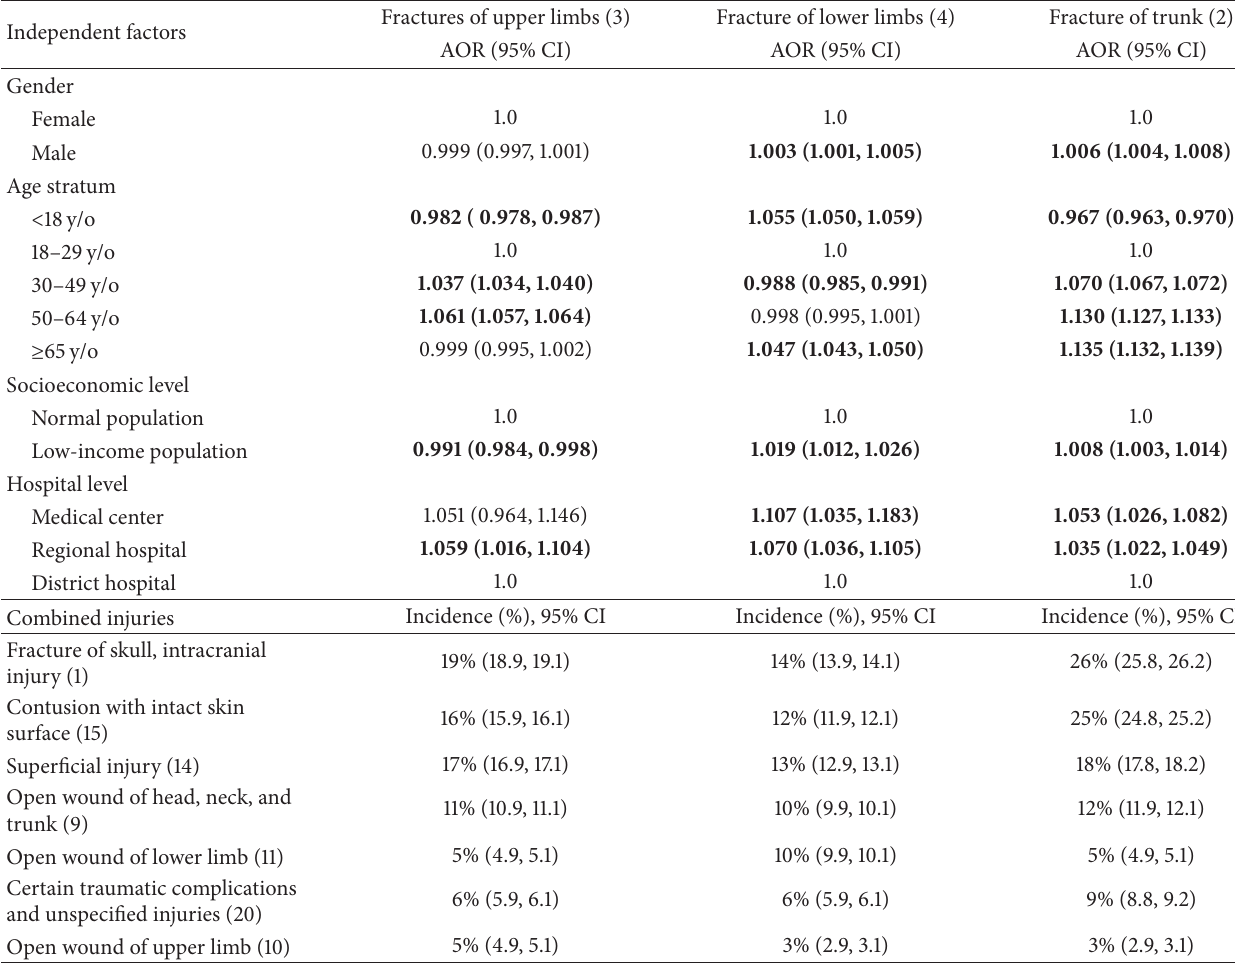
Table 3: Individual and cluster differences of orthopedic fractures analyzed by the multiple logistic regression and distributions of their major combined